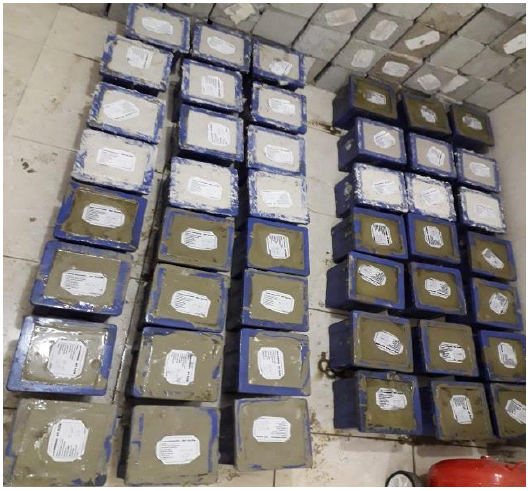
Figure 4. Mixtures prepared for optimum binding.